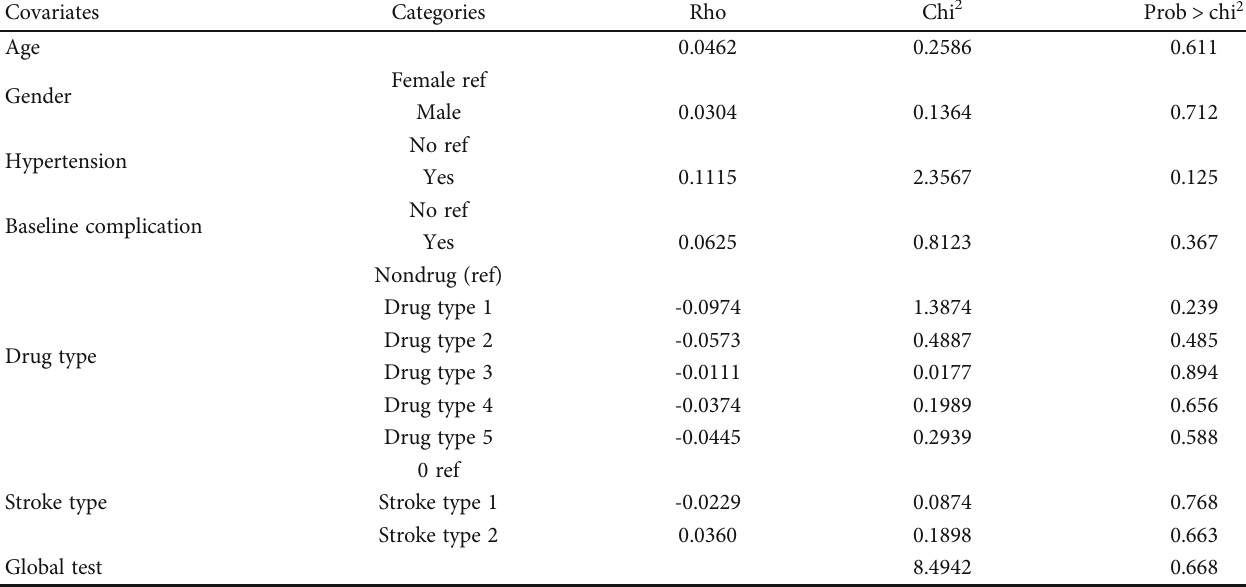
Table 5: Schoenfeld residual for each covariate.